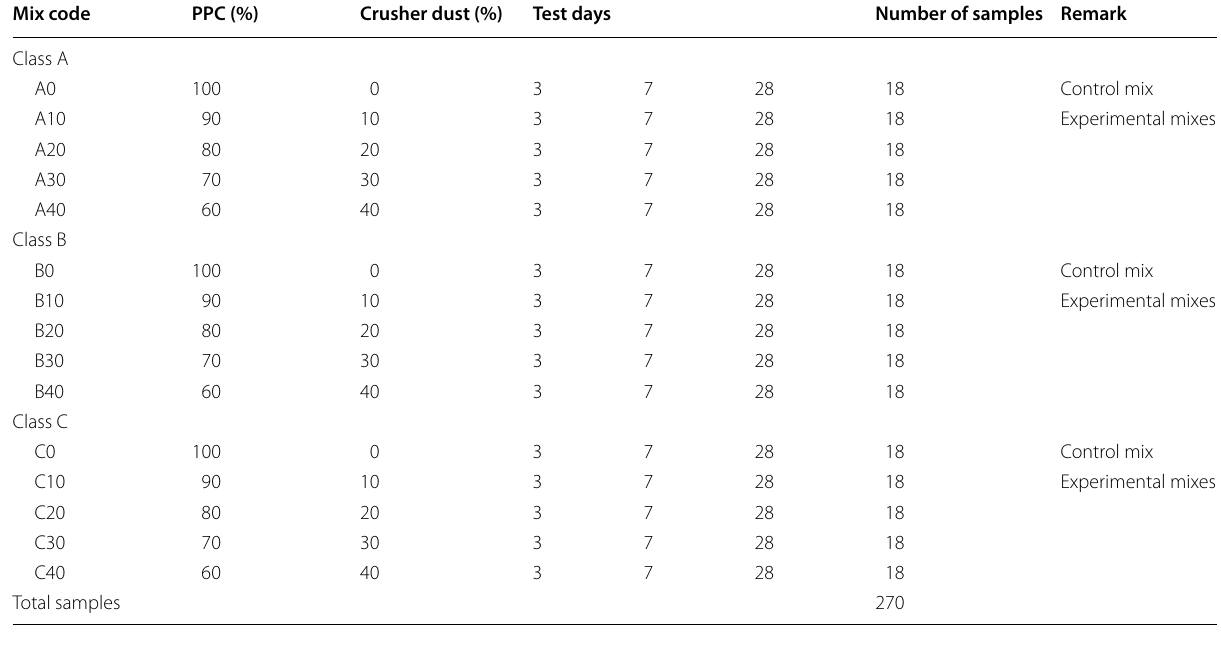
Table 5 Mix code and their description for HCB samples.